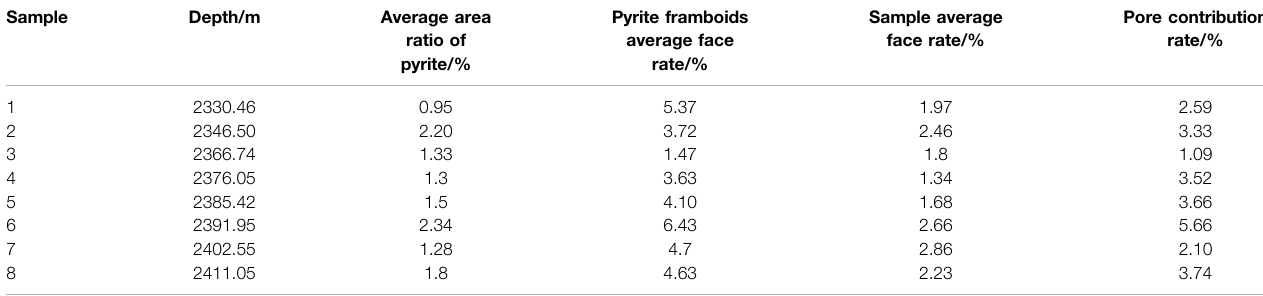
TABLE 3 | Quantitative statistical results of pores in pyrite framboids of shale samples from X2 well. Sample Depth/m Average area ratio